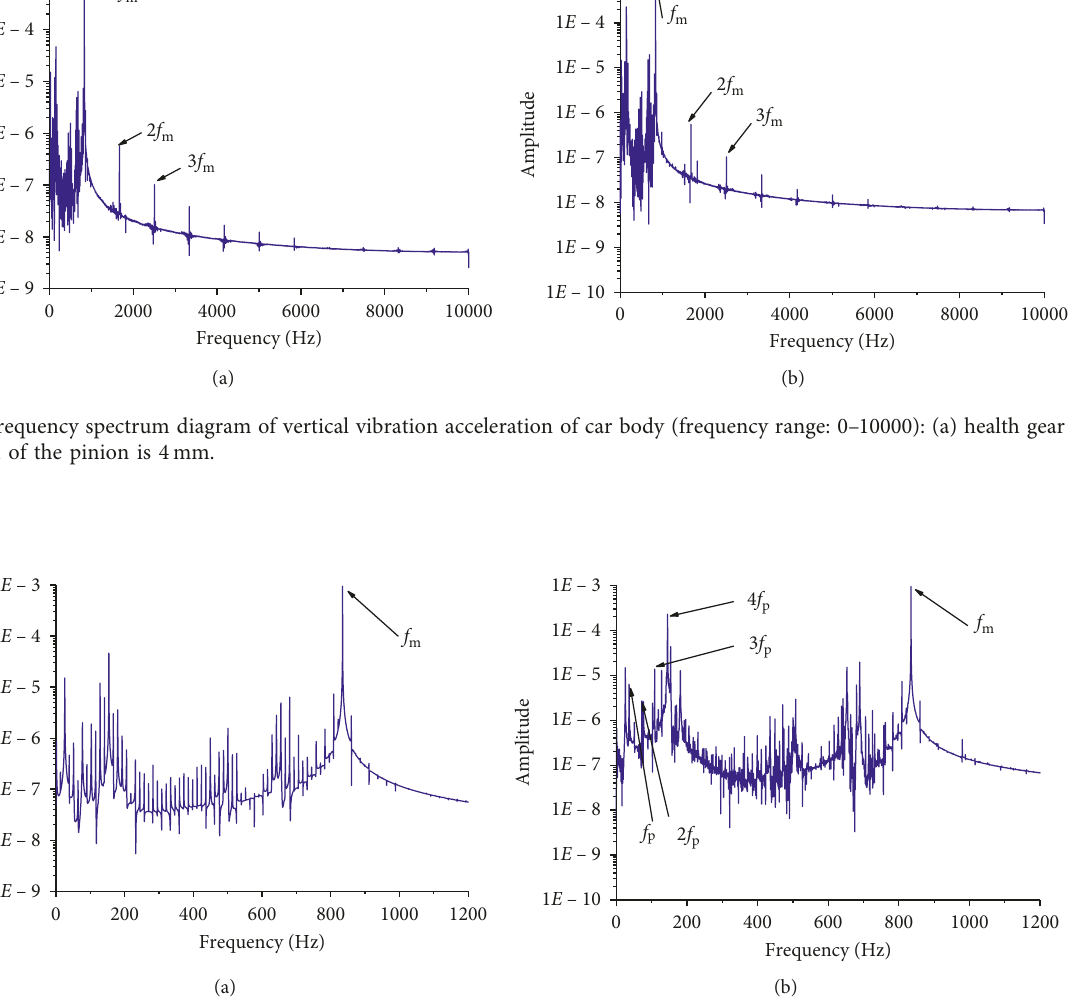
Figure 8: Frequency spectrum diagram of vertical vibration acceleration of car body (frequency range: 0–1200): (a) health gear (b) the crack length of the pinion is